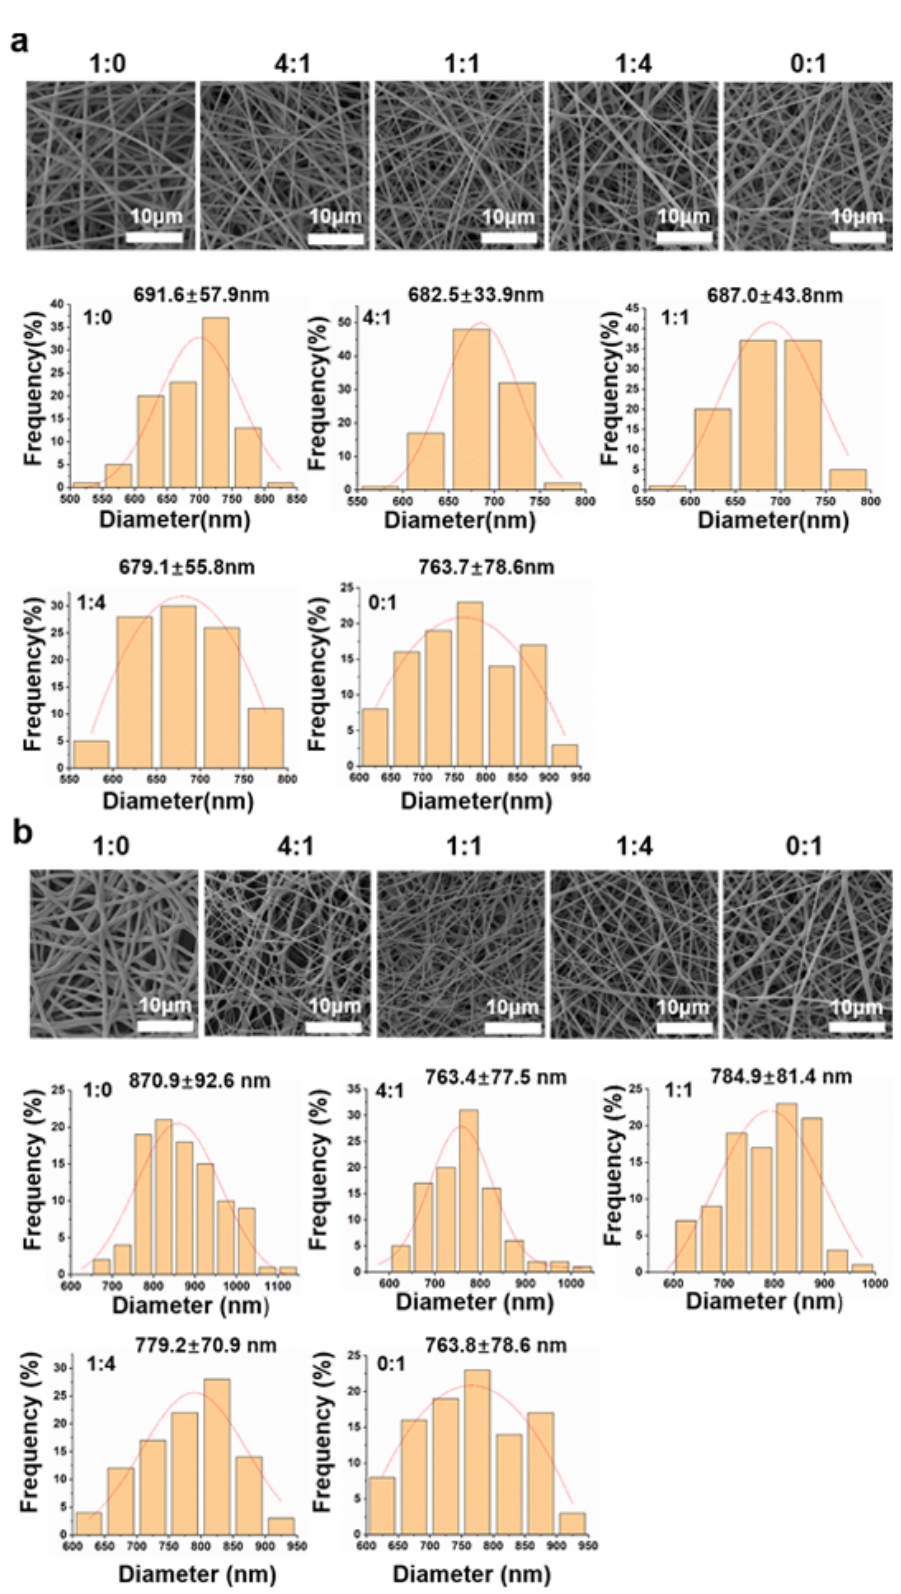
Figure 2. The SEM images and the frequency of the fiber diameter distribution of nanofiber mats with different MeGel/PLLA weight ratios, i.e., MeGel/PLLA = 1:0, 4:1, 1:1, 1:4, and 0:1: ( a ) before UV crosslinking and ( b ) after UV cross ‐ linking.